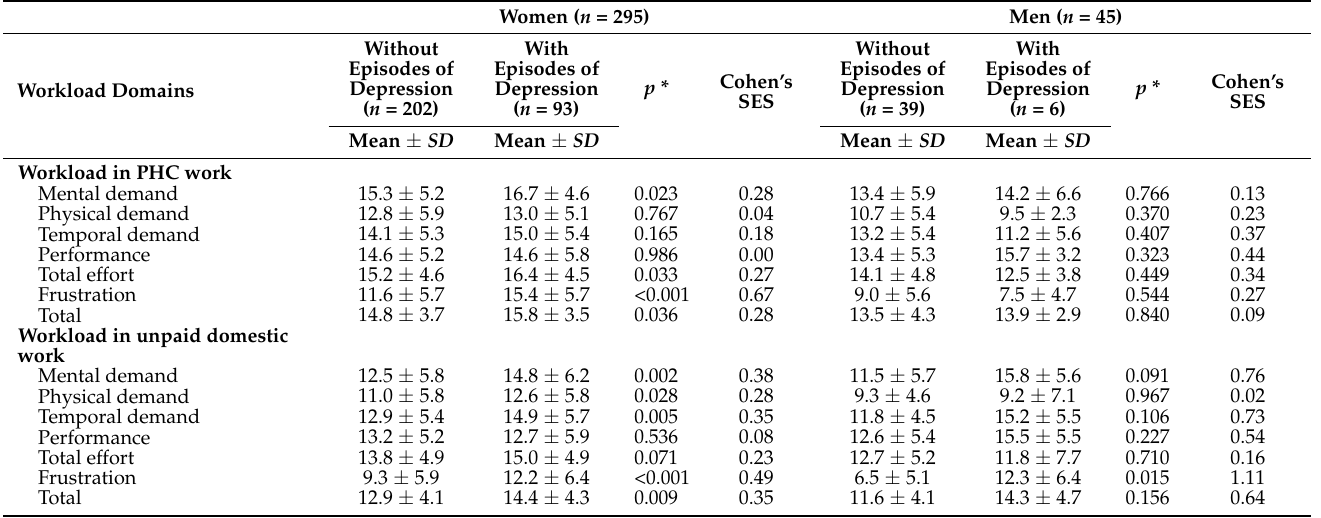
Table 4. Comparison by gender of the health care professionals in terms of PHC workload and unpaid domestic work, according to the presence or absence of episodes of depression. Women ( n = 295) Men ( n = 45) Workload